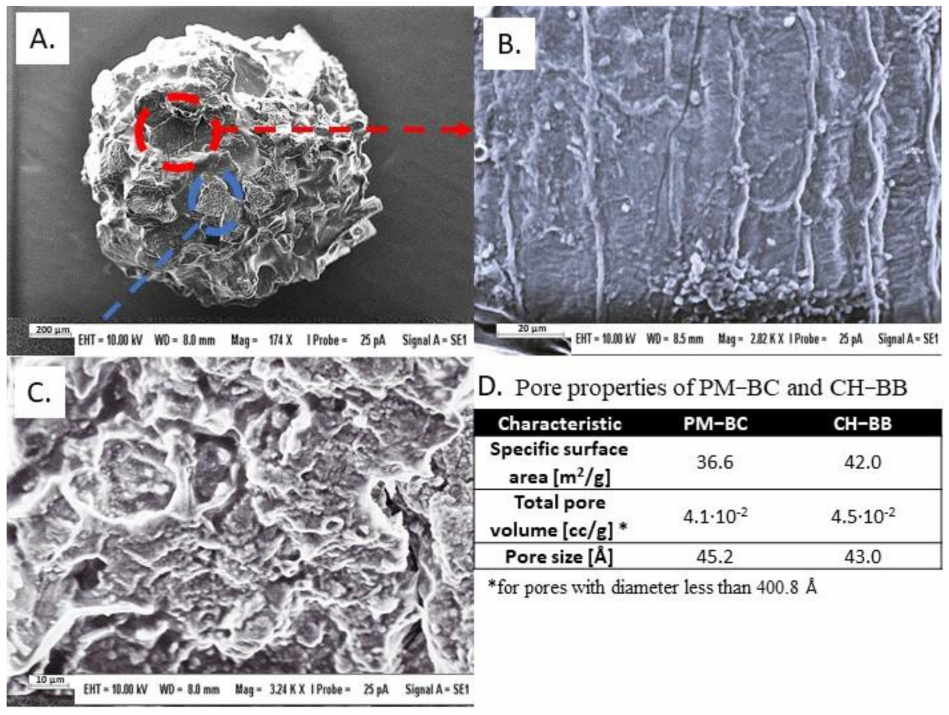
Figure 2. SEM images of chitosan-biochar beads ( A – C ); ( D ) pore properties of pig manure biochar (PM-BC) and chitosan-biochar beards (CH-BB).